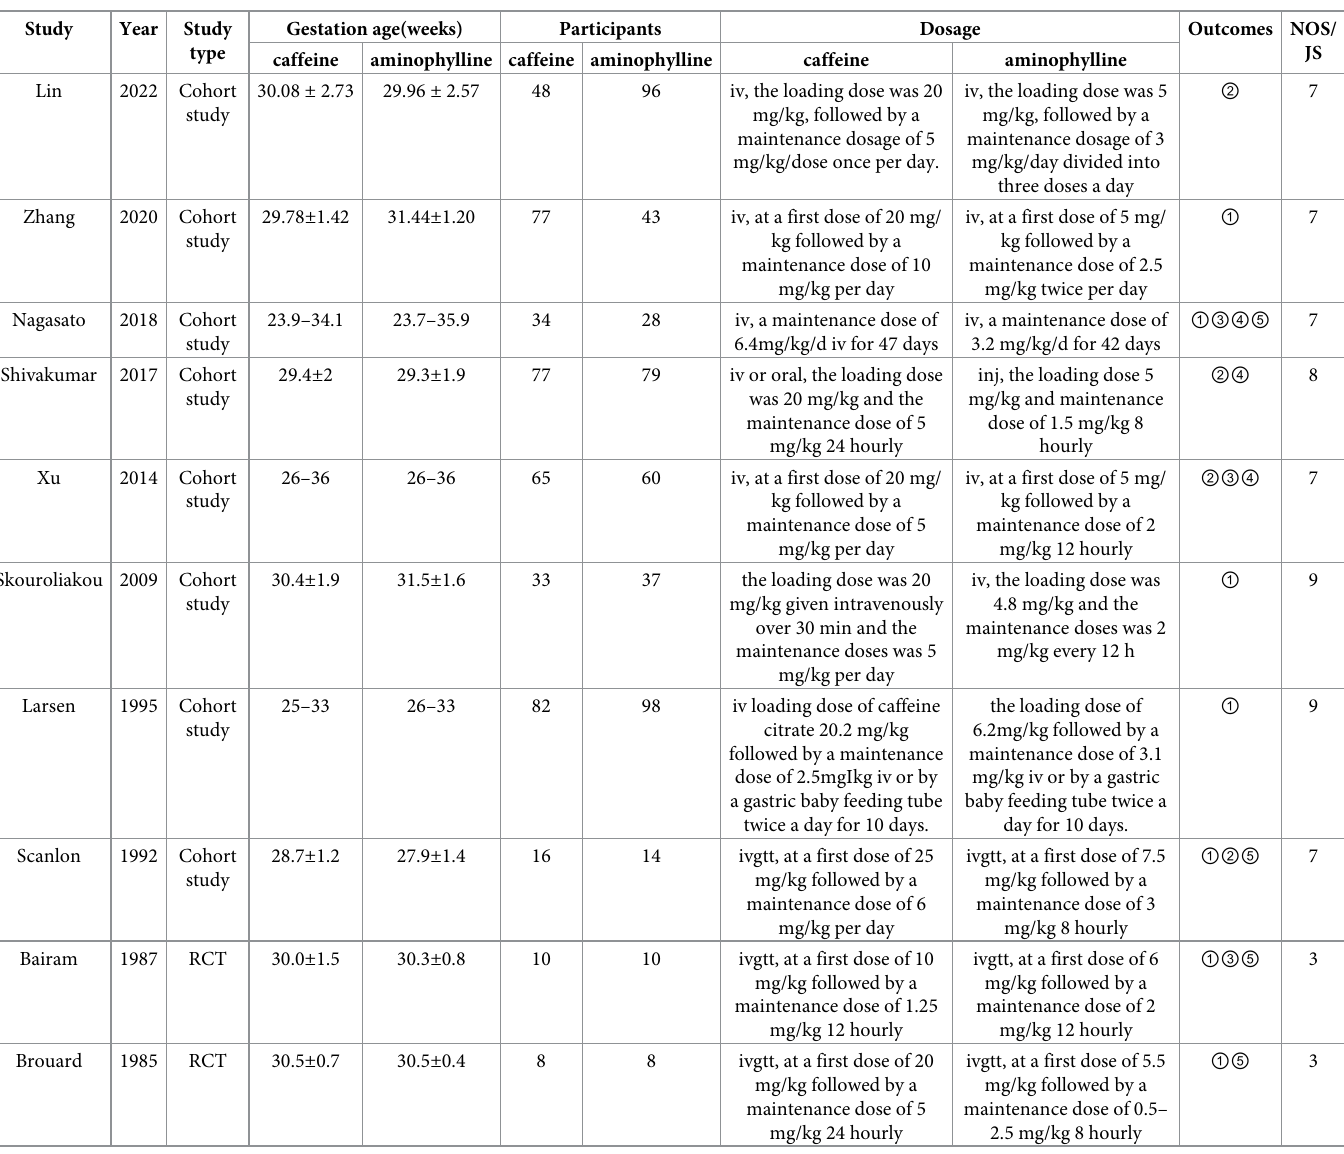
Table 1. Characteristics of included